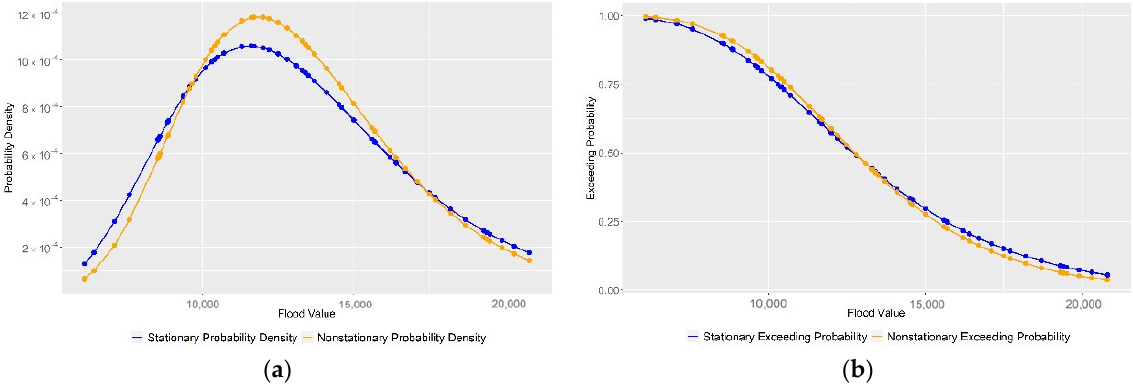
Figure 11. The probability density distribution curves and exceedance probability distribution curves for models LN S (the blue curves) and average LN C -3 (the orange curves). ( a ) Probability density distribution curve; ( b ) Exceedance probability distribution curve.